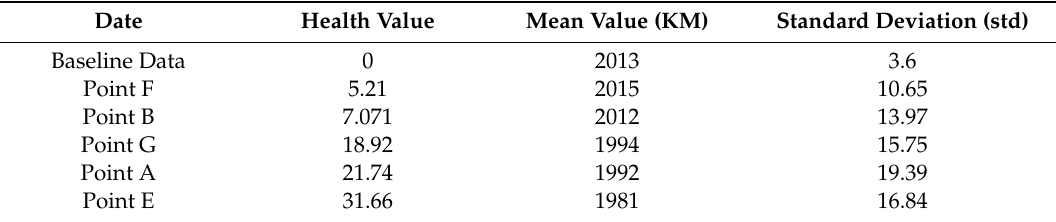
Table 1. State parameters for di ff erent